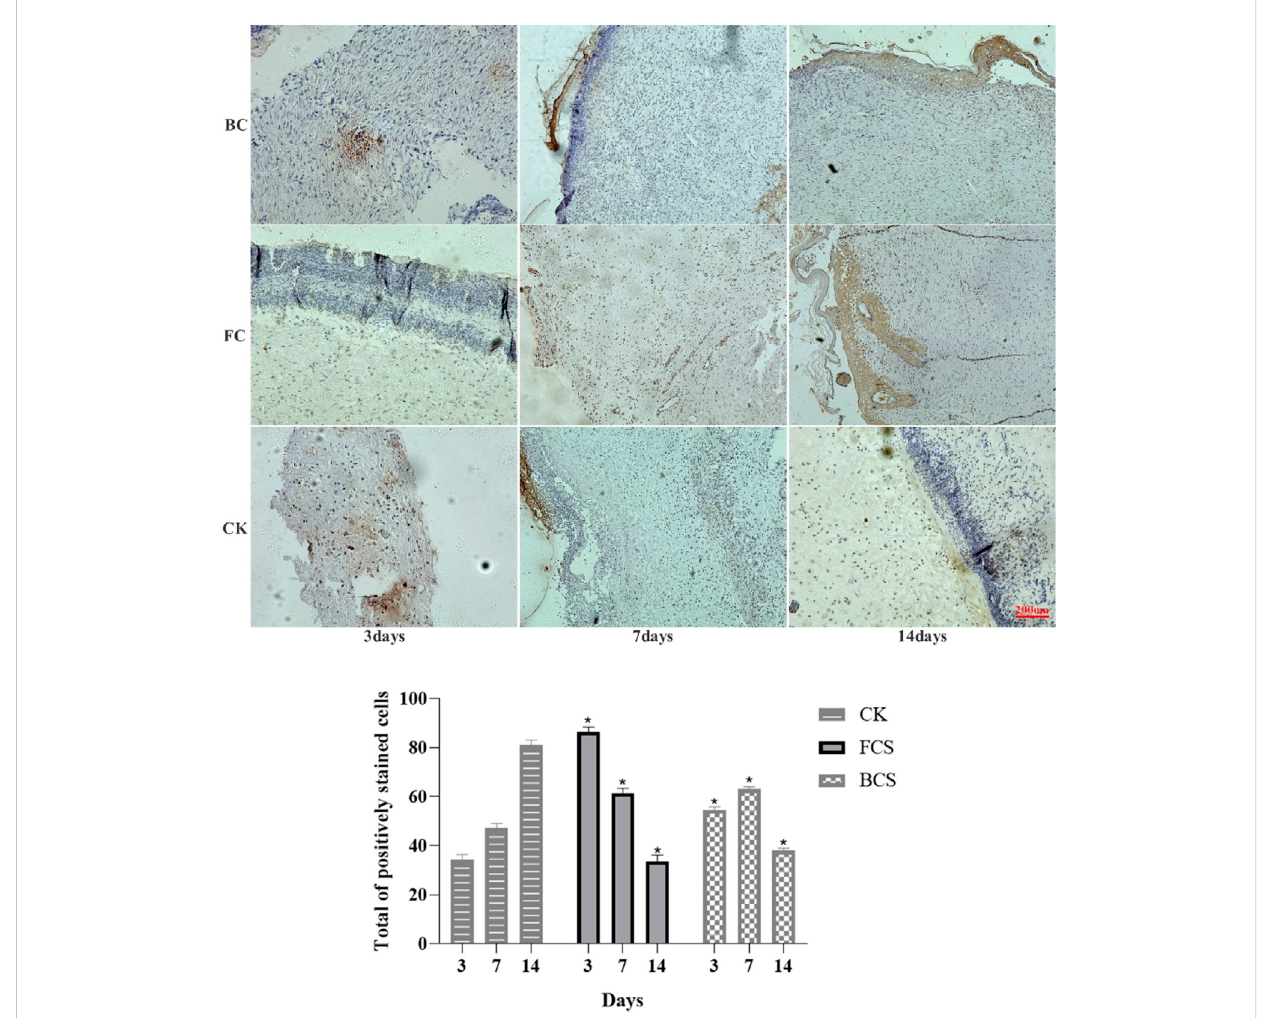
FIGURE 6 Immunohistochemical analysis of FGF expression in wounded tissues (Magni fi cation, ×100). Note: FGF is mainly expressed in fi broblasts, which are coloredduringimmunohistochemistryanddistributedinthesurface,middleandbottomlayers.thehistogramshowedthetotalofpositivelystainedcells of FGF in the dermal tissue per group. (Each bar represents the mean ± SD; * p < 0.05: signi fi cantly different from the control